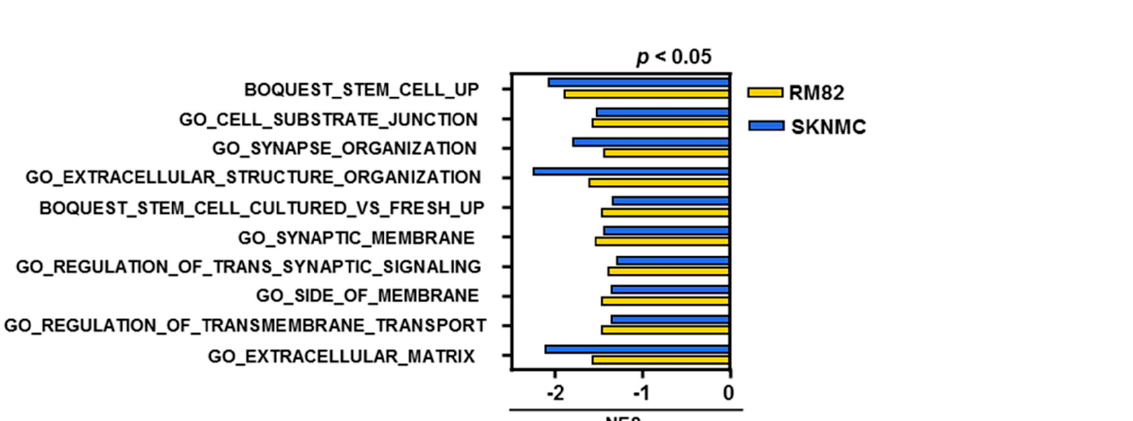
Figure 3. ENG and MMP14 regulate transcriptional pathways related to cell migration and cell– substrate adhesion in ES cells. ( A ) Joint transcriptomic analysis of the shENG models from RM82 and SK-N-MC revealed common downregulated GO terms related to cell–substrate adhesion and